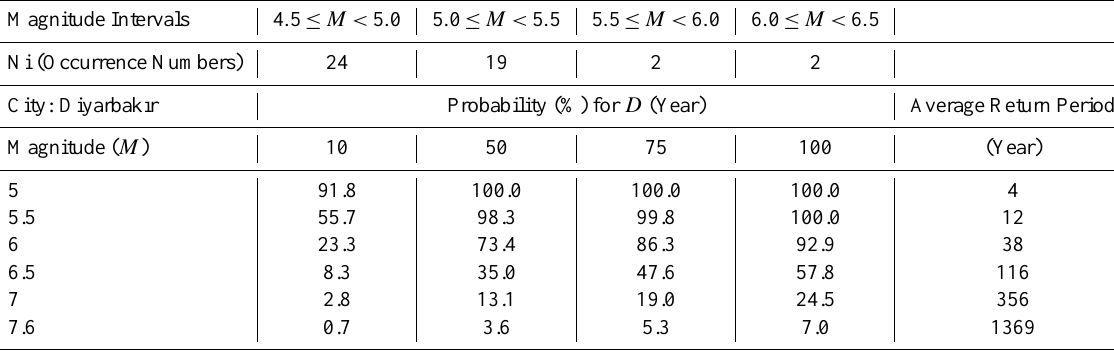
Table 3g. Earthquake occurrence probability (%) for D (Year) for Diyarbakır city. Magnitude Intervals